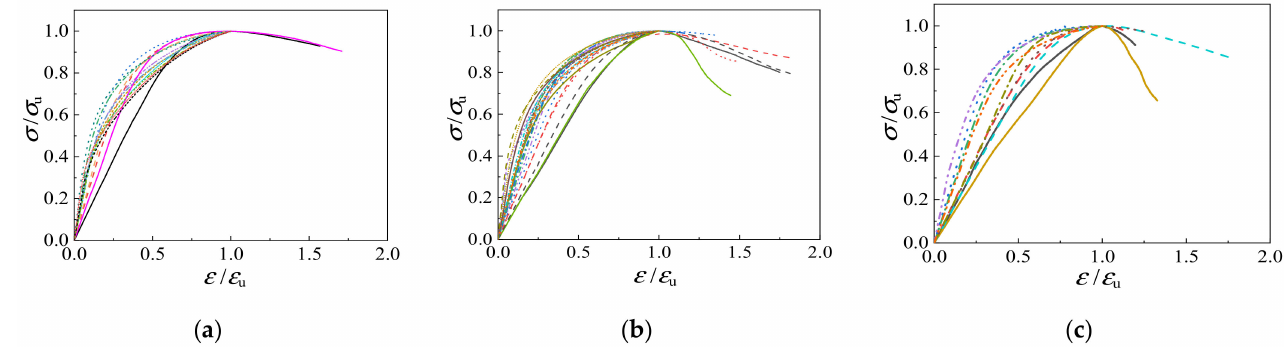
Figure 18. Triaxial dimensionless stress-strain curves. ( a ) LAC20, ( b ) LAC30, ( c ) LAC40.